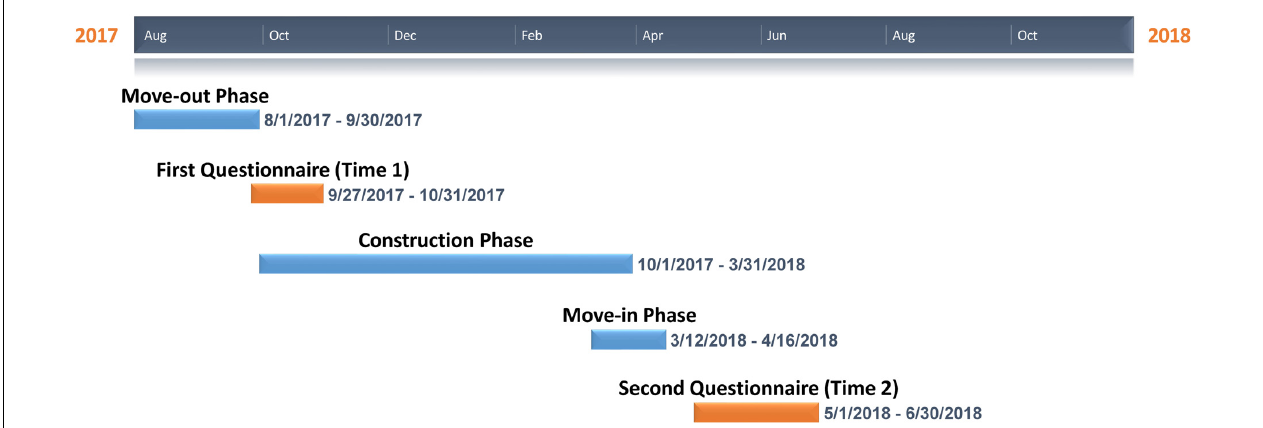
FIGURE 1 | Timeline of the retrofit and questionnaire distribution.